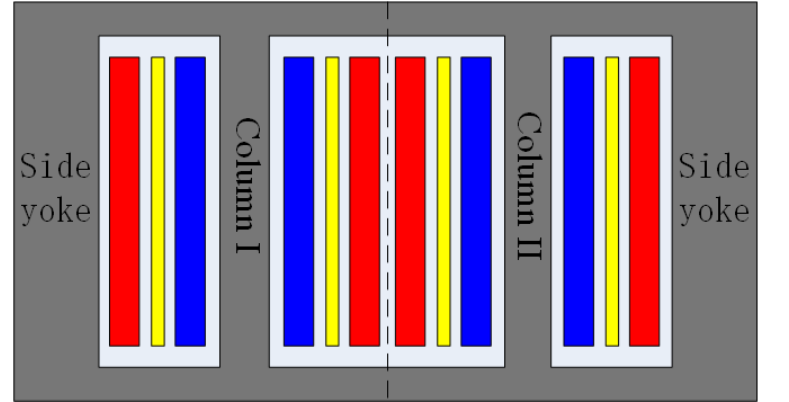
Figure 2. Structural model of single-phase transformer.